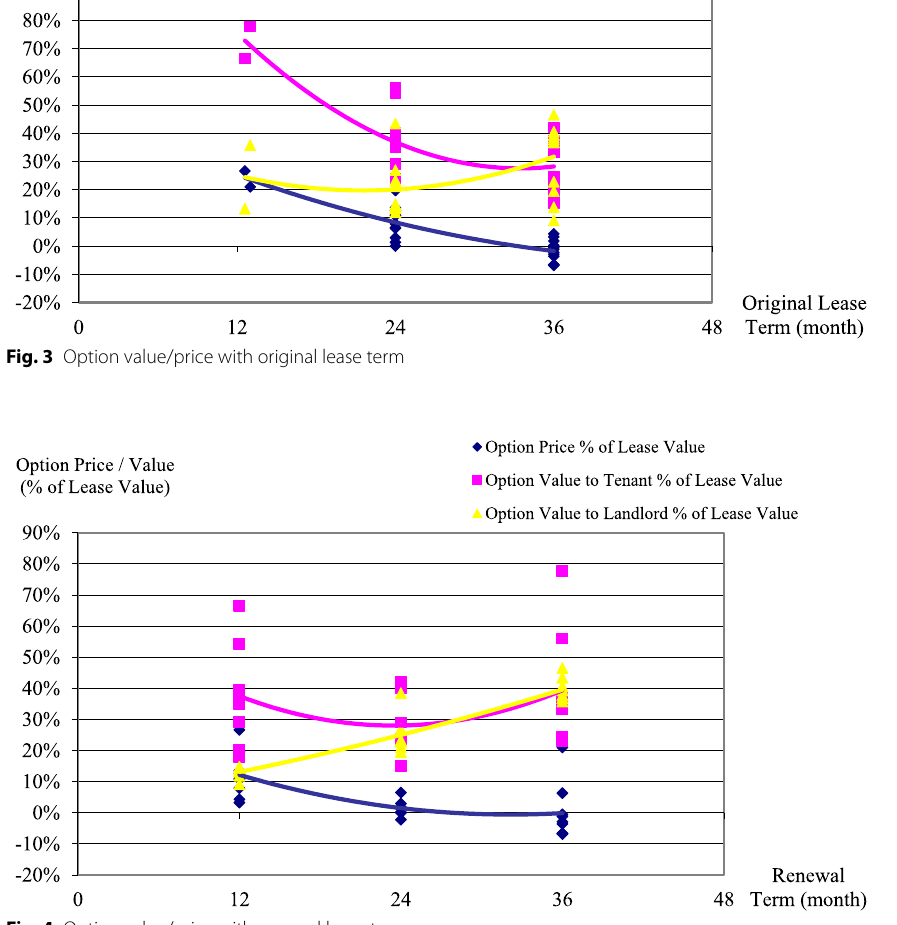
Fig. 4 Option value/price with renewal lease